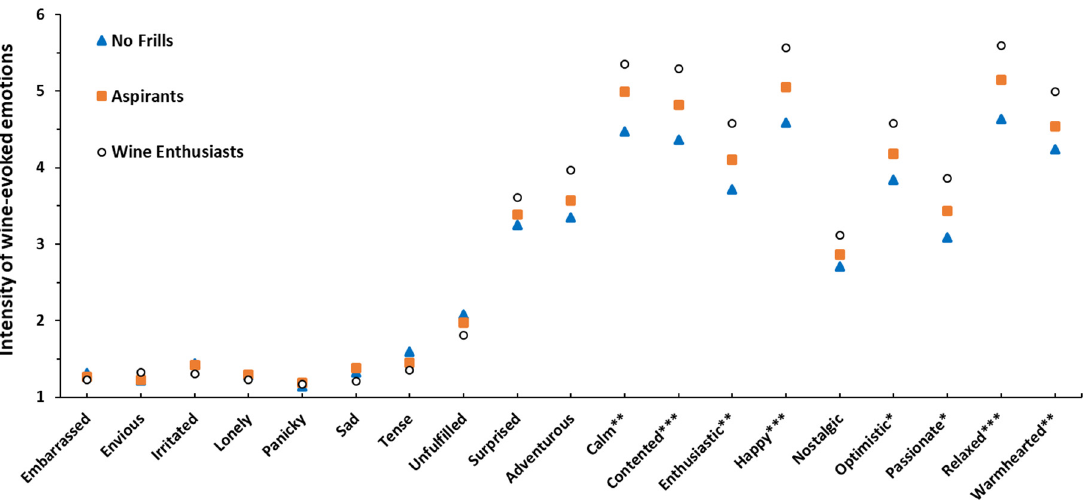
Figure 4. Reported wine evoked emotions for the 3 fine wine segments (FWS), pooled for context and samples. Emotion intensities were measured on a 9-point scale, ranging from 1 = not at all to 9 = extremely. * indicates significant differences between FWS at p < 0.05, ** at p < 0.01 and *** at p < 0.001.